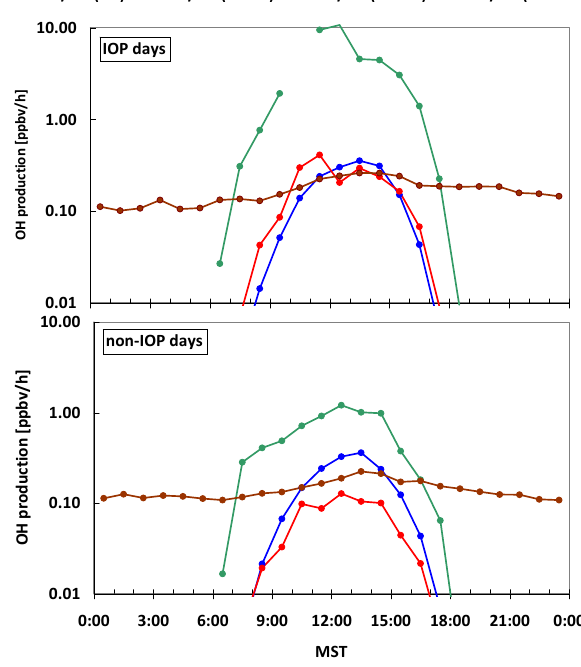
Figure 13. OH production due to photolysis of O 3 , HCHO, HONO, and alkene ozonolysis for IOP and non-IOP days. Photolysis rates were calculated using the TUV model 5.0 (TUV, 2010) considering the altitude of the Boulder site. Data for the snow surface albedo, the total ozone column and the total aerosol optical depth (AOD) at 550nm for each day of the time frame 28 February–3 March 2011 were obtained from the European MAAC model reanaly- sis (http://data-portal.ecmwf.int/data/d/macc_reanalysis/). The cor- responding values ranged 0.63–0.76 (snow surface albedo), 306– 381 Dobson units (total ozone column), and 0.128–0.448 (total AOD). Calculated photolysis rates were further adjusted using the ratio of TUV-calculated surface UV radiation versus observed in- coming UV radiation at the Boulder site for each hour of the field